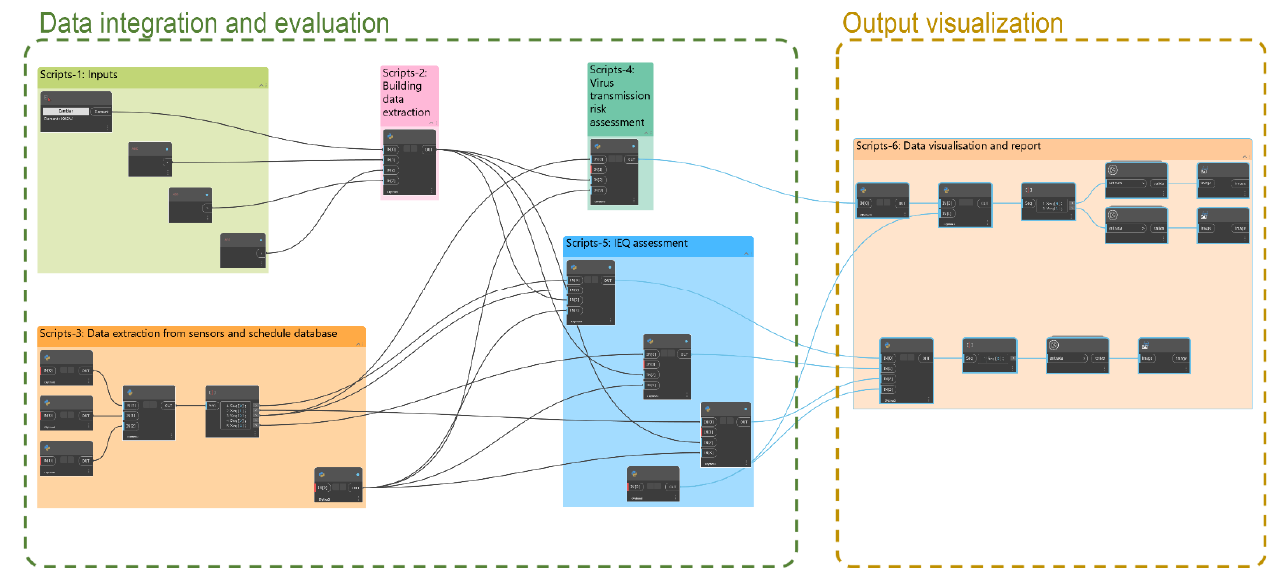
Figure 3. Overview of the diagram of the scripts developed using Dynamo. Table 3. Characteristics of teaching